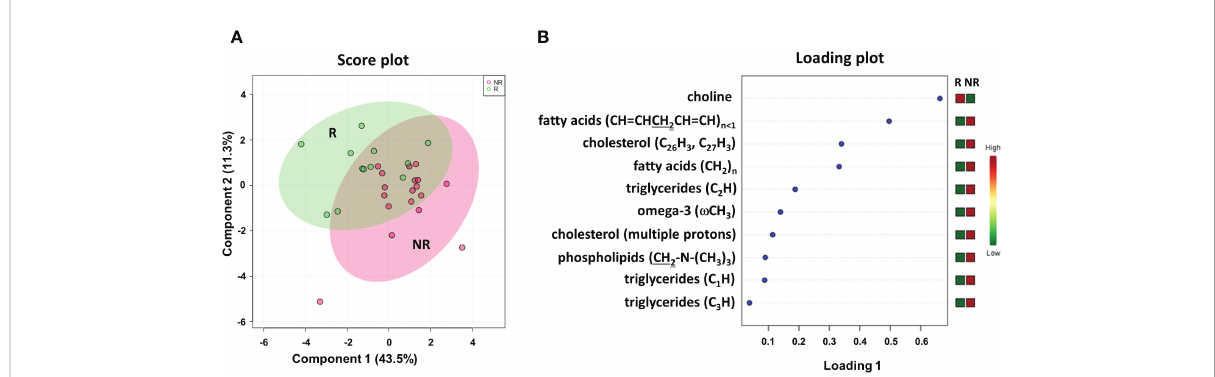
favorable prognostic TRG1-2, displayed a worse prognosis, further highlighting the powerful role of lipid metabolites in DFS prediction (Figure 7B). Similar data for phospholipids and triglycerides were also obtained for OS (Figure 13S).